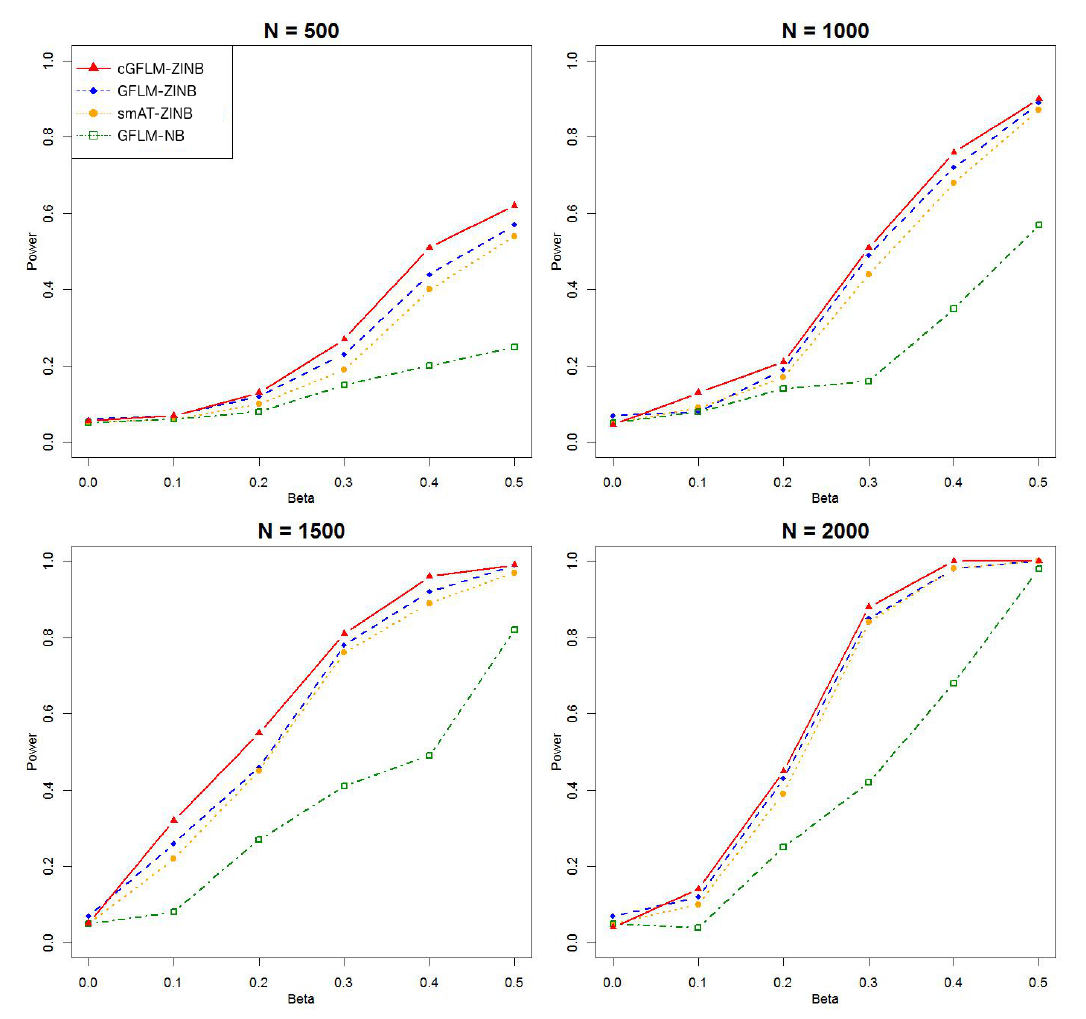
Figure 5. Power simulation for ZINB outcomes based on random LD blocks, two causal loci, effect in latent Bernoulli distribution.